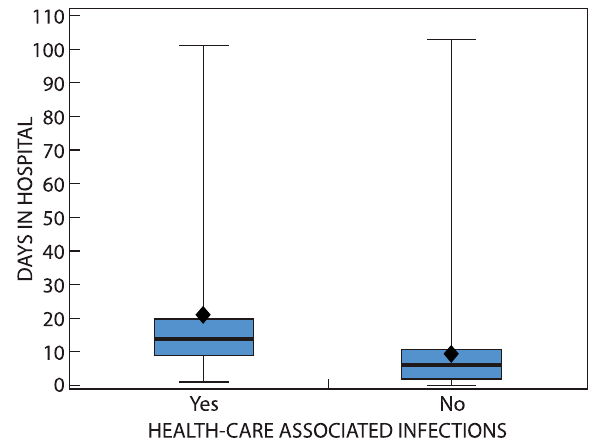
Figure 1: Boxplot of days in hospital for patients with and without healthcare-associated